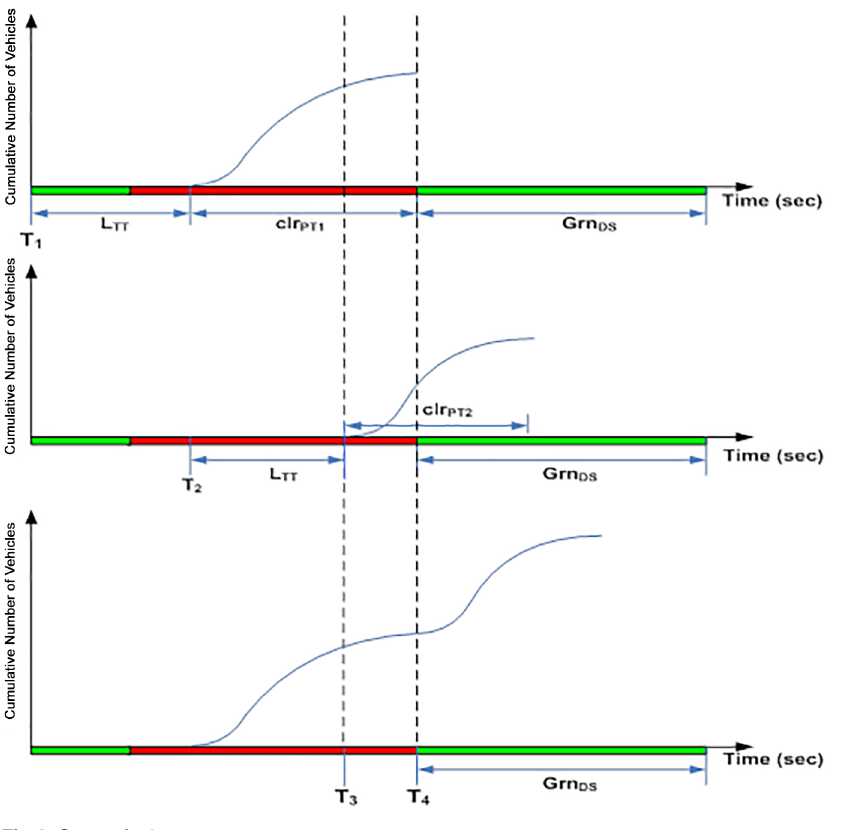
Fig 4. Scenario 1.